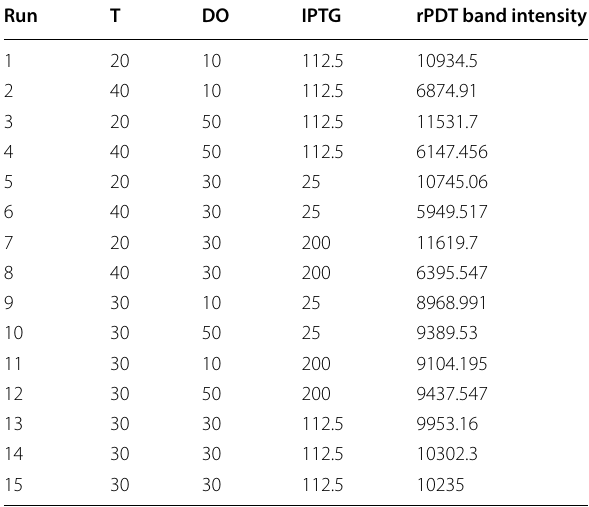
Table 2 Box–Behnken design